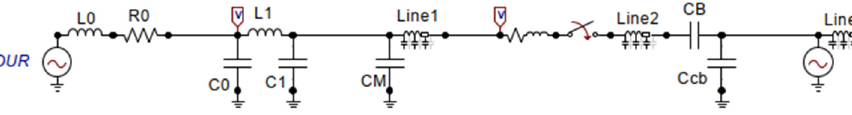
Figure 3. Simulation model of VFTO. Table 1. Equivalent model and parameter values of GIS equipment components.